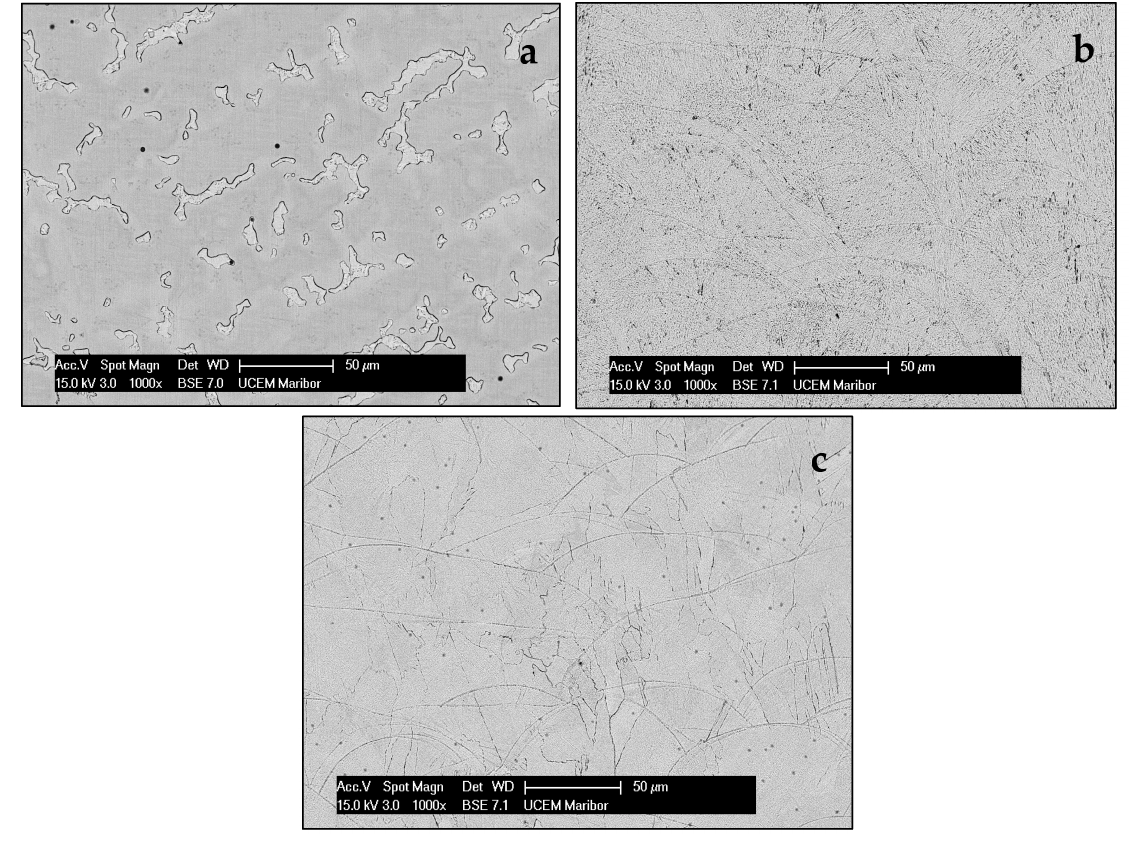
Figure 4. SEM microstructure of samples ( a ) C, ( b ) S1 and ( c ) S3.